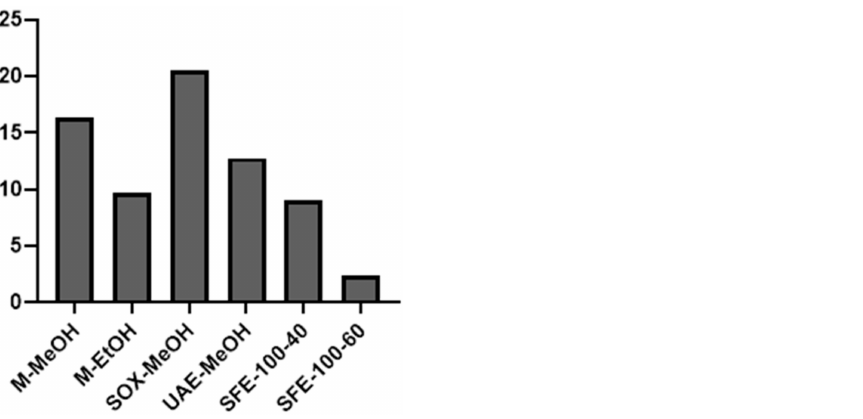
Figure 1. Extraction yield (EY) with different extraction methods (maceration with methanol— M-MeOH, maceration with ethanol—M-EtOH, Soxhlet extraction with methanol—SOX-MeOH, ultrasound-assisted extraction—UAE, supercritical CO 2 extraction at 100 bar and 40 ◦ C—SFE-100- 40, supercritical CO 2 extraction at 100 bar and 60 ◦ C—SFE-100-60). Data are expressed as weight percentage (wt %) of the extracts obtained per 100 g of dry flower